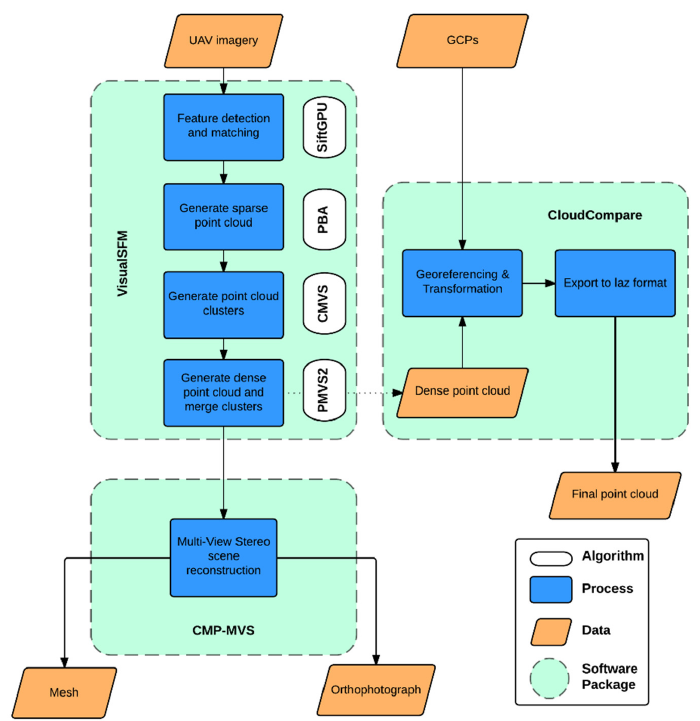
Figure 3. SfM and MVS workflow in VisualSFM, CMP-MVS and CloudCompare. Four different algorithms are executed in VisualSFM to generate a dense point cloud.